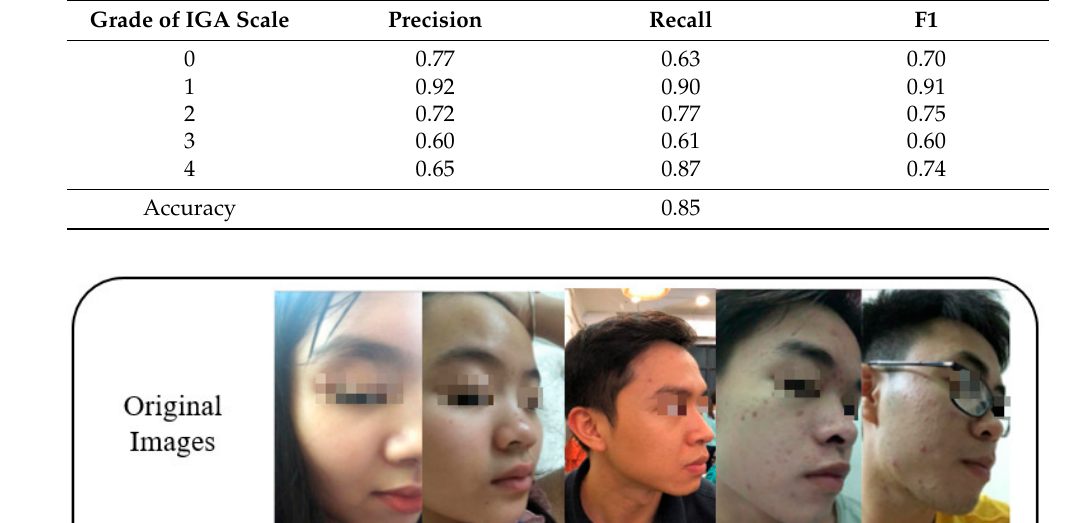
Table 5. Precision, recall, F1 score, and accuracy of acne grading model.